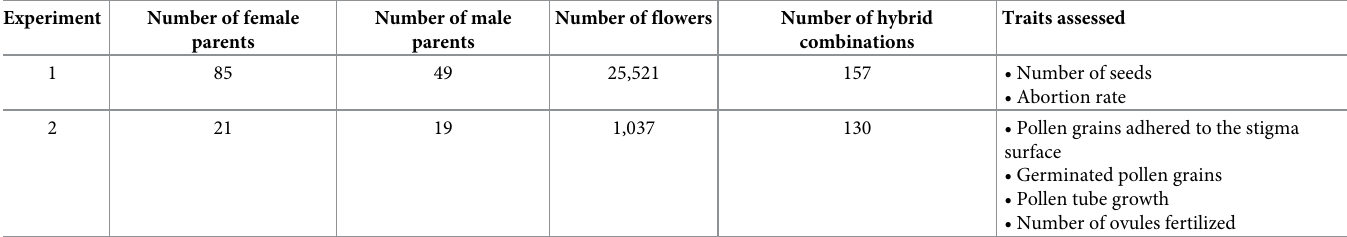
Table 1. Number of genotypes used as parents in controlled crosses and the number of flowers, hybrid combinations, and characteristics assessed in each experiment.